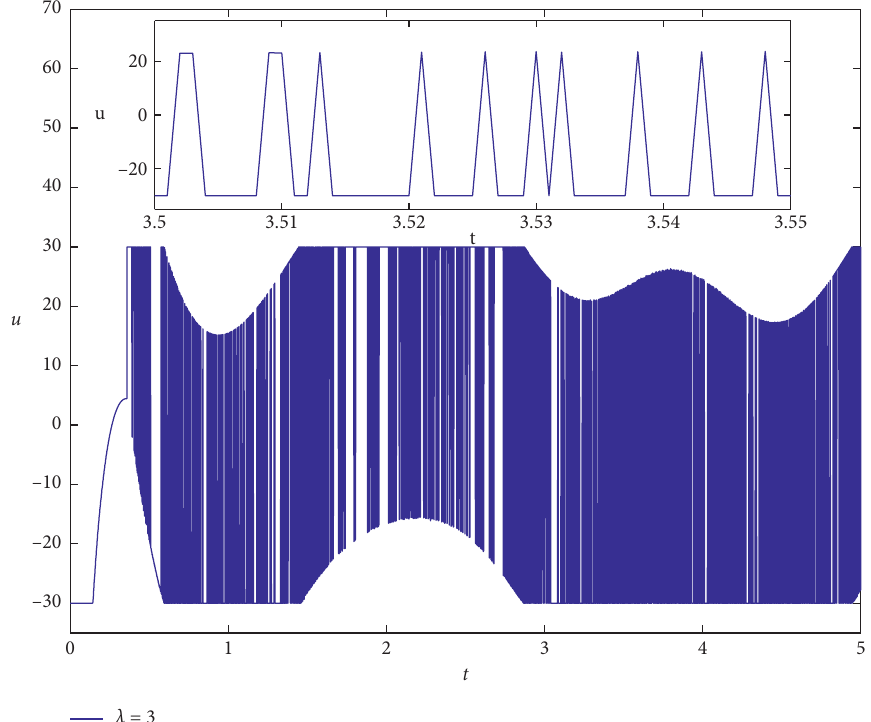
Figure 7: The time response of input signal u with λ �